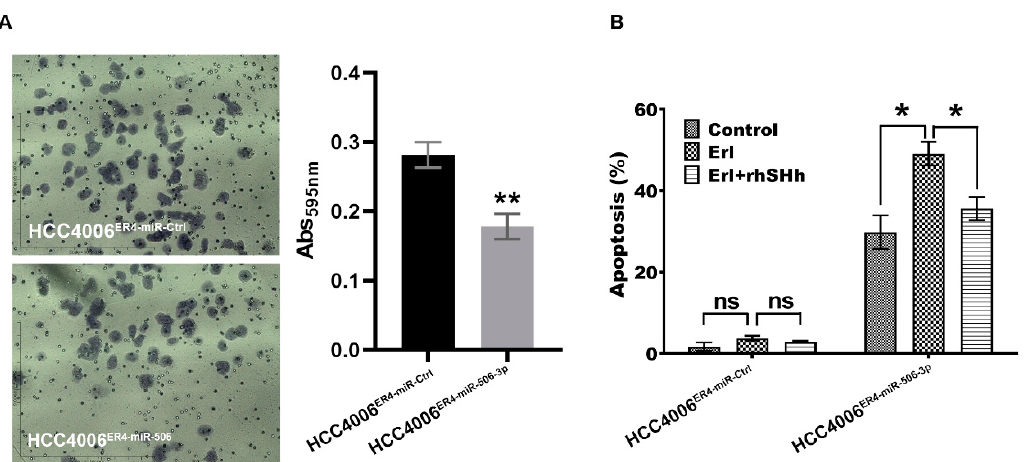
Figure 5. Migration and apoptotic activity of erlotinib-resistant cells and miR-506-3p-overexpressing erlotinib-resistant cells. ( A ) The migratory potential of HCC4006 ER4-miR-Ctrl and HCC4006 ER4-miR-506-3pOE cells was determined by the transwell migration assay. The photomicrographs represent the difference in the in vitro migration of HCC4006 ER4-miR-Ctrl and HCC4006 ER4-miR-506-3pOE cells toward the serum for 24 h (Magnification, 10×). Histogram showing crystal violet absorbance at 595 nm. Values in the bar graphs represent the mean ± SD ( n = 6). ** p < 0.001 compared to HCC4006 ER-miR-Ctrl cells. ( B ) Overexpression of miR-506-3p vectors in HCC4006 ER4 cells promoted apoptosis after exposure to erlotinib which is counteracted by treatment with both erlotinib and rhSHH protein. Data are expressed as the mean ± SD, ** p < 0.001.